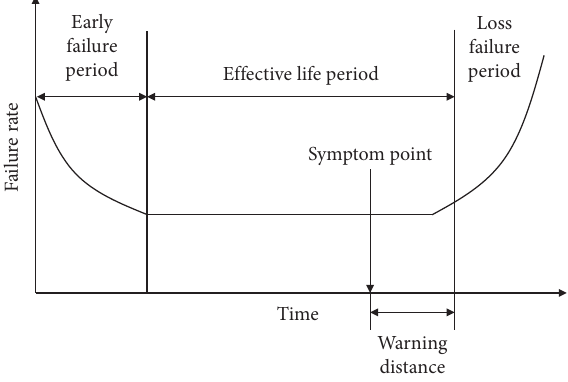
Figure 6: Life prediction